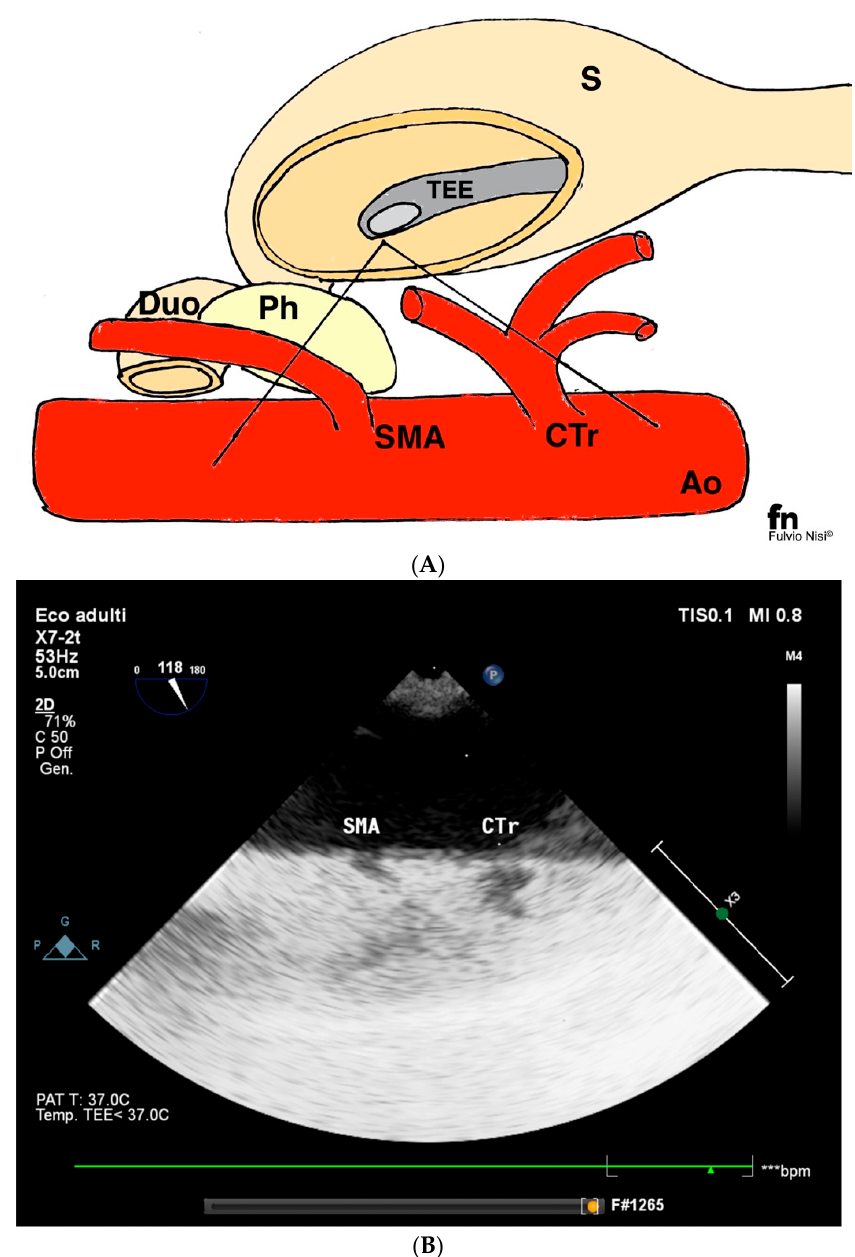
Figure 1. ( A ): Scanning planes and images at the level of the celiac trunk (CTr) and superior mesenteric artery (SMA) in the longitudinal scan of the aorta (Ao). The stomach (S), duodenum (Duo), and pancreatic head (Ph) are displayed. ( B ): The TEE probe (TEE) can be seen through a virtual section of the stomach wall. The orientation of ultrasound beam is shown by means of two continuous lines (longitudinal to the aortic major axis). The illustration was created by one of the authors (F.N.).